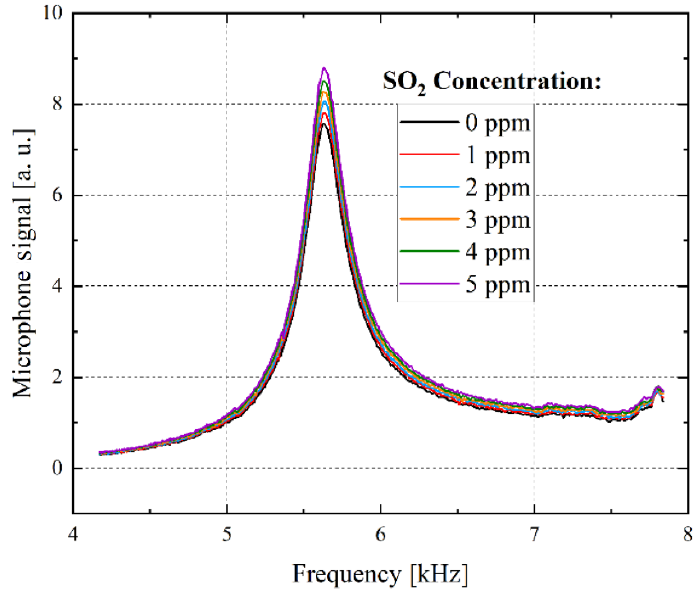
Figure 6. Sensor response during exposure to SO 2 . The SO 2 concentration was varied from 0 to 5 ppm in 1 ppm steps. A resolution of one ppm is achieved. The microphone signal peak height increases with increasing SO 2 concentrations. [16.]